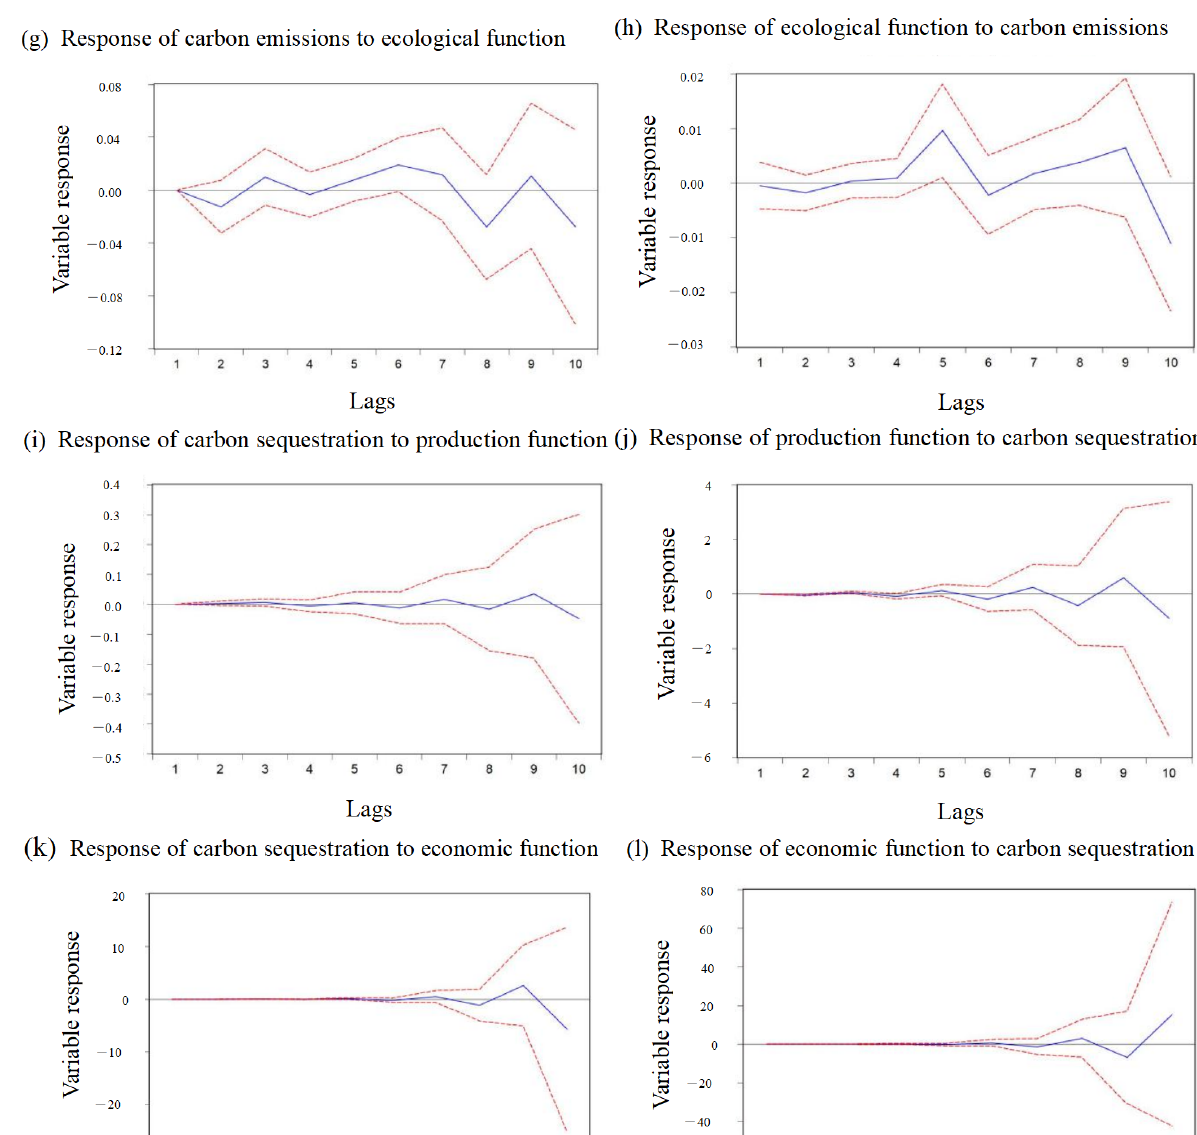
Figure 8. Impulse response function of carbon effects and agricultural multifunctionality. 3.4. Temporal Characteristics of the Associative Degree between Multifunctionality and Carbon Effects of Urban Agriculture The associative degree between the production function and carbon emissions as well as carbon sequestration is the highest compared with other functions. The associative degree between the production function and carbon sequestration (0.862) is greater than that between the production function and carbon emissions (0.826), showing that the car- bon sink is the role of the agricultural production system more than the carbon source. In contrast, the associative degree between economic function and carbon emissions (0.803) is greater than that between the economic function and carbon sequestration (0.786), showing that agriculture tends to act as a carbon source in the pursuit of economic bene- fits. The associative degree between the social function and carbon sequestration (0.796) is greater than that between the social function and carbon emissions (0.768). The role of agriculture as a carbon sink is stronger than that of a carbon source when it exerts social functions such as providing employment, wage and service products. The associative de- gree between the ecological function and carbon effects is the lowest, and its contribution to carbon effects is limited (Figure 9). According to the multifunctionality of urban agriculture in Guangzhou from 2002 to 2020 (Figure 3) and the change in its degree of association with carbon effects (Figure 10), the interactive development process of urban agricultural multifunctionality and carbon effects can be divided into three stages. The first stage was from 2002 to 2006 when agri- culture in Guangzhou was dominated by the production function, and the economic and social functions were relatively weak. At this time, the associative degree between the economic function and carbon emissions was at a high level (the average associative de- gree between 2002 and 2006 was 0.813) and showed an increasing trend. The associative degree between the production function and carbon emissions (the average associative degree between 2002 and 2006 was 0.780) was less than that of the economic function. The associative degree between the social function and carbon emissions was lower (the aver- age associative degree between 2002 and 2006 was 0.721). The associative degree between the ecological function and carbon emissions first decreased and then increased, with an